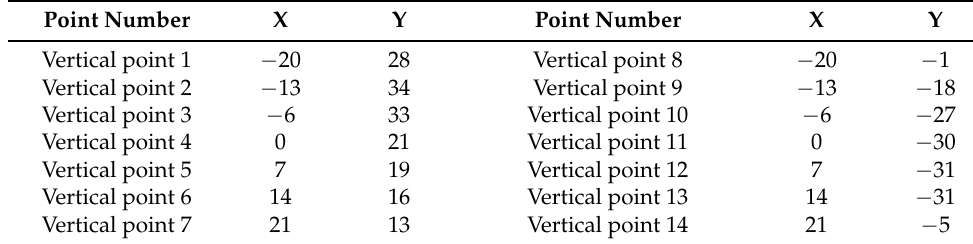
Table 5. The coordinates of grain 1 (G1) boundary information points (vertical